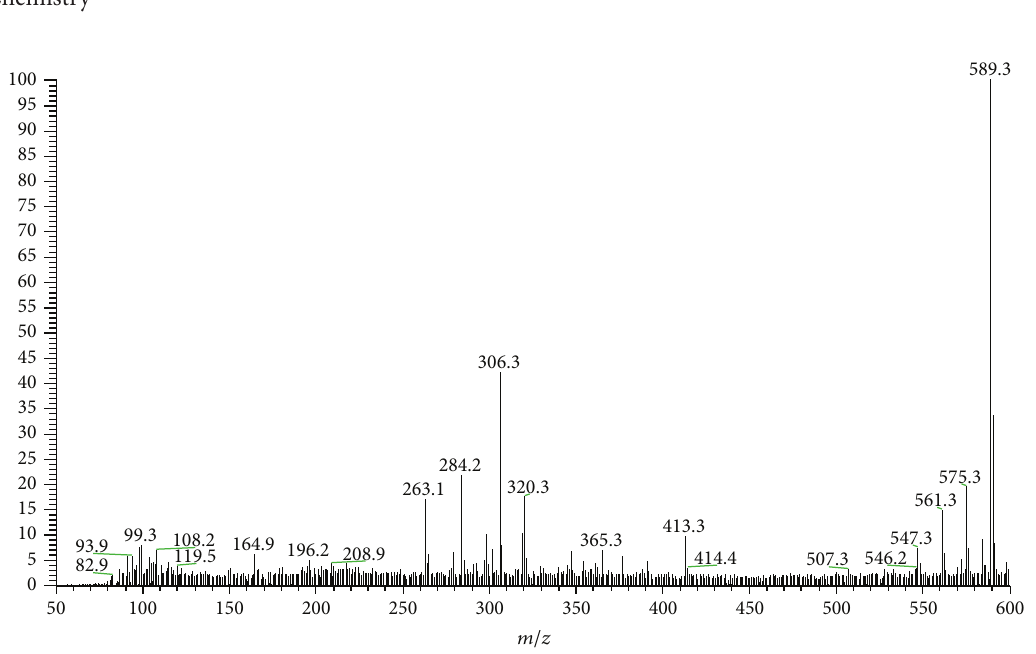
Figure 1: ESI-MS total ion chromatogram of crude R. emodi MeOH fraction.